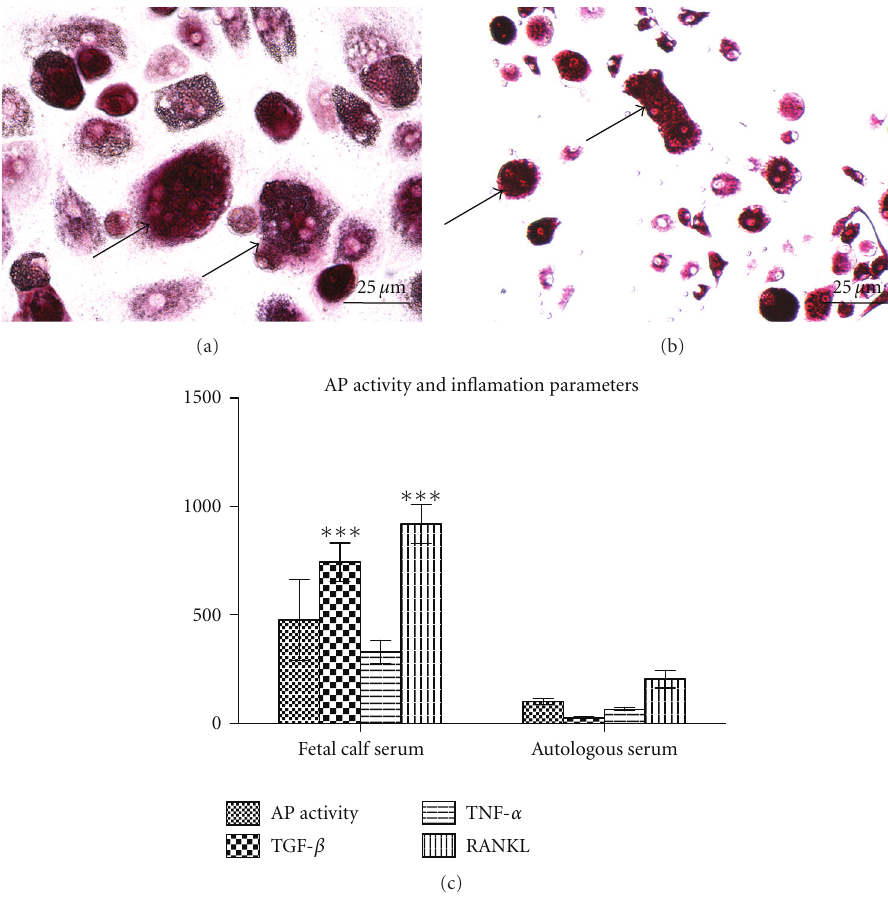
Figure 5: Di ff erentiation procedure activates and maturates monocytes. TRAP staining of giant cells (marked with → ) occurring after di ff erentiation treatment of PCMOs with medium containing vitamin D (a) and osteoclasts (b); magnification 200x. (c) Comparison of Alkaline phosphatase [ μ mol/min]-, TNF-alpha [pg/mL]-, TGF-beta [pg/mL], and RANKL-[pg/mL] levels normalized to SRB in PCMOs either isolated and di ff erentiated in medium containing fetal calf or autologous serum ( N = 5, n = 3). Di ff erentiation performed with osteogenic medium containing vitamin D ( ∗ P < 0,05; ∗∗∗ P < 0 .